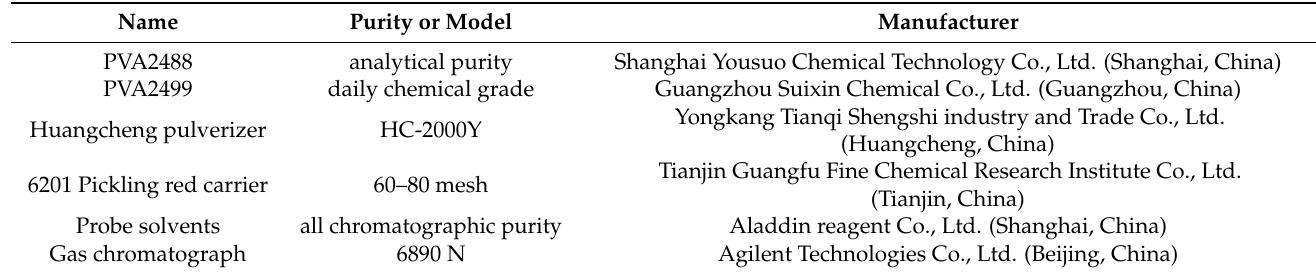
Table 1. Experimental drugs and instruments.